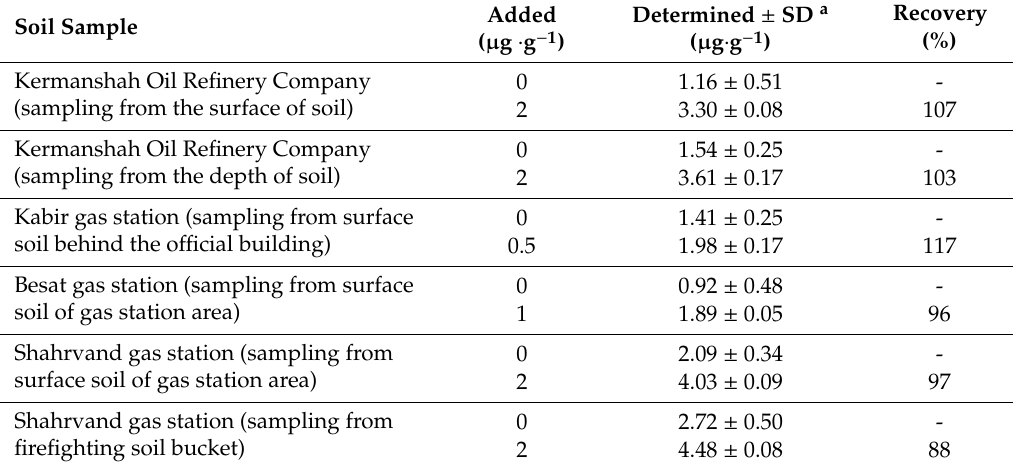
Analysis and recovery of MTBE in polluted soil samples, using